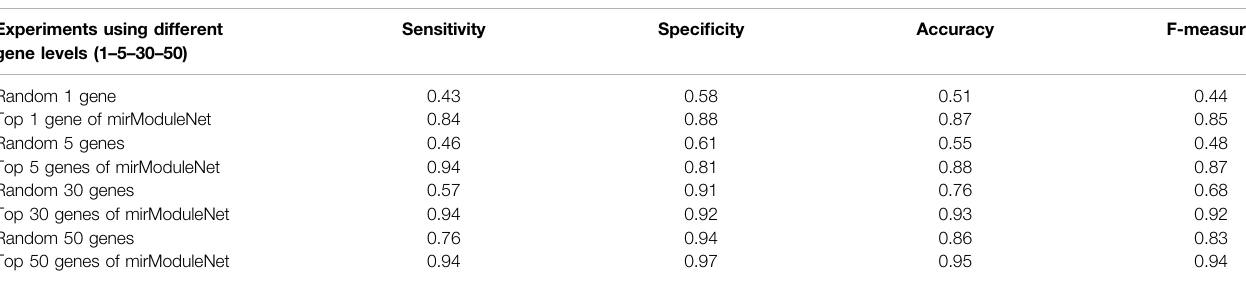
TABLE 7 | Performance results on the external validation